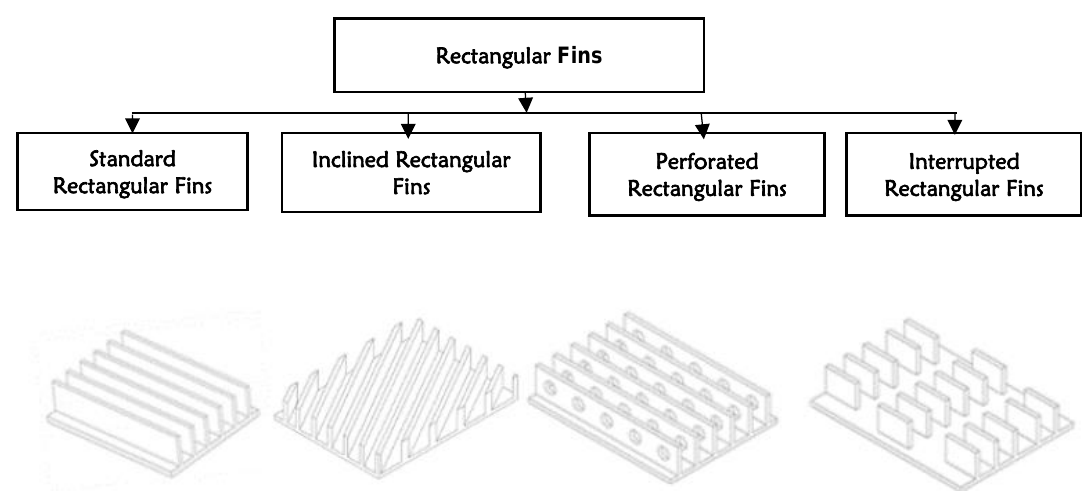
Figure 1. Different rectangular fin types and schematic view of the fin arrays [4]